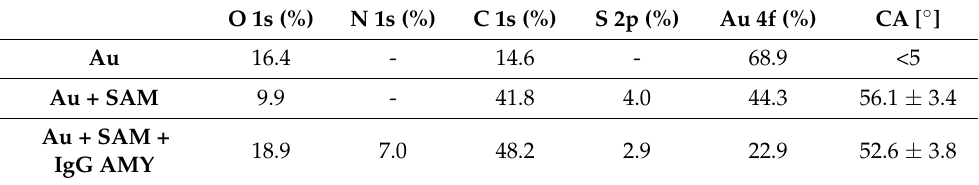
Table 1. XPS characterization at 0 ◦ take-off angle and contact angle measurements on bare gold surface (Au), after α -lipoic acid coating (Au + SAM) and after antibody immobilization (Au + SAM + IgG AMY). XPS standard error does not exceed the 1–2% of the reported